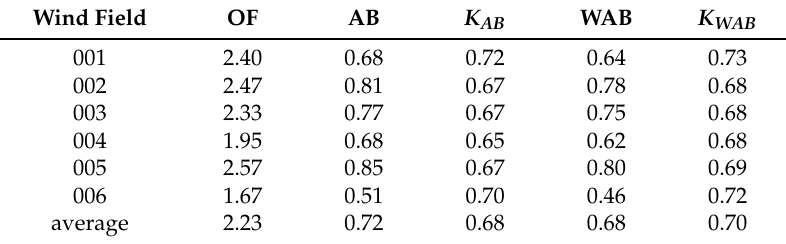
Table 3. Mean bias (m/s) and change rate K (%) of original forecasts (OF), average bias correction (AB), and weather adapted bias correction (WAB) outputs from the ensemble average